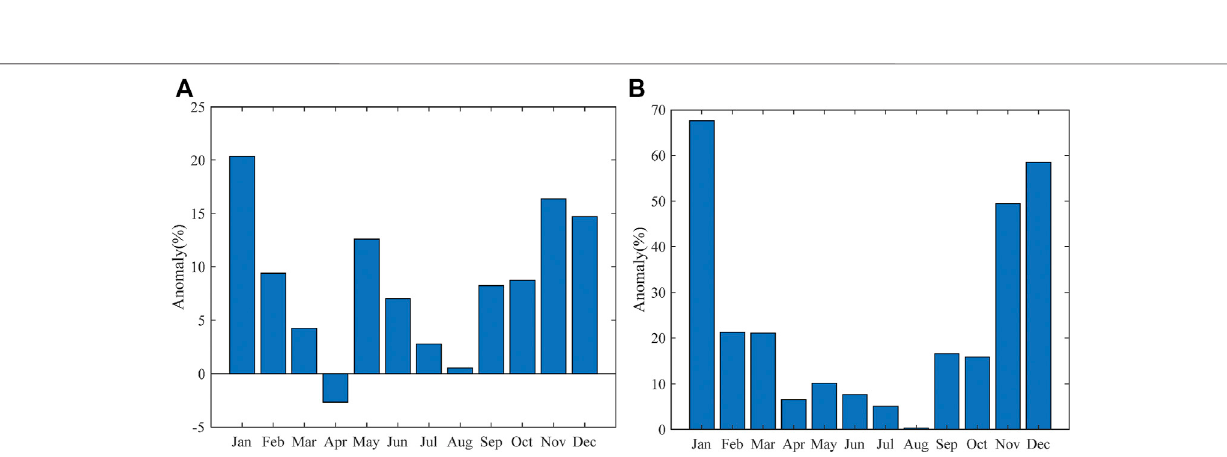
Frontiers in Environmental Science |